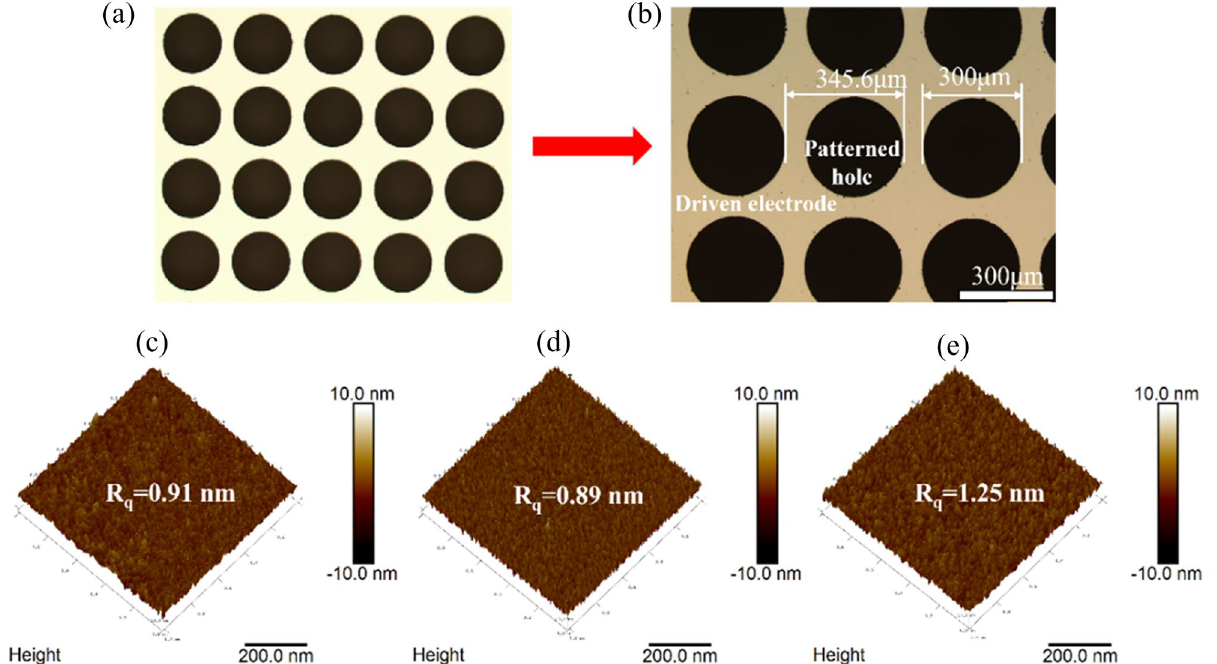
Figure 1. ( a ) Microscope image of the fabricated Hi-R electrode arrays. ( b ) Magnified microscope image of ( a ); and ( c – e ) 3D AFM images of AZO Hi-R layer, and their thickness are approximately 20 nm, 30 nm and 50 nm, respectively.